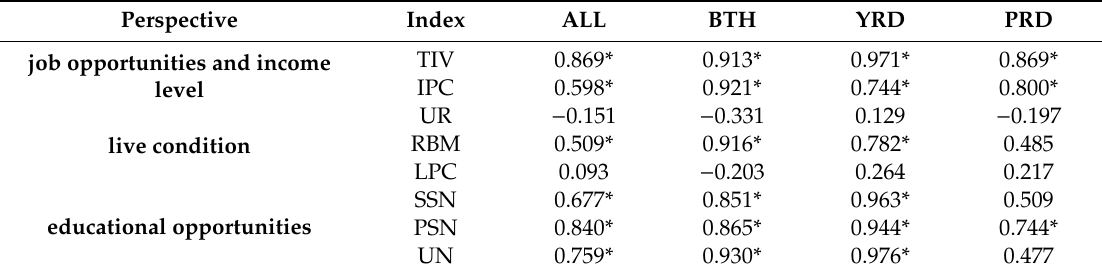
Table 6. Correlation coe ffi cient between external-MAI and urban pulling indicators.